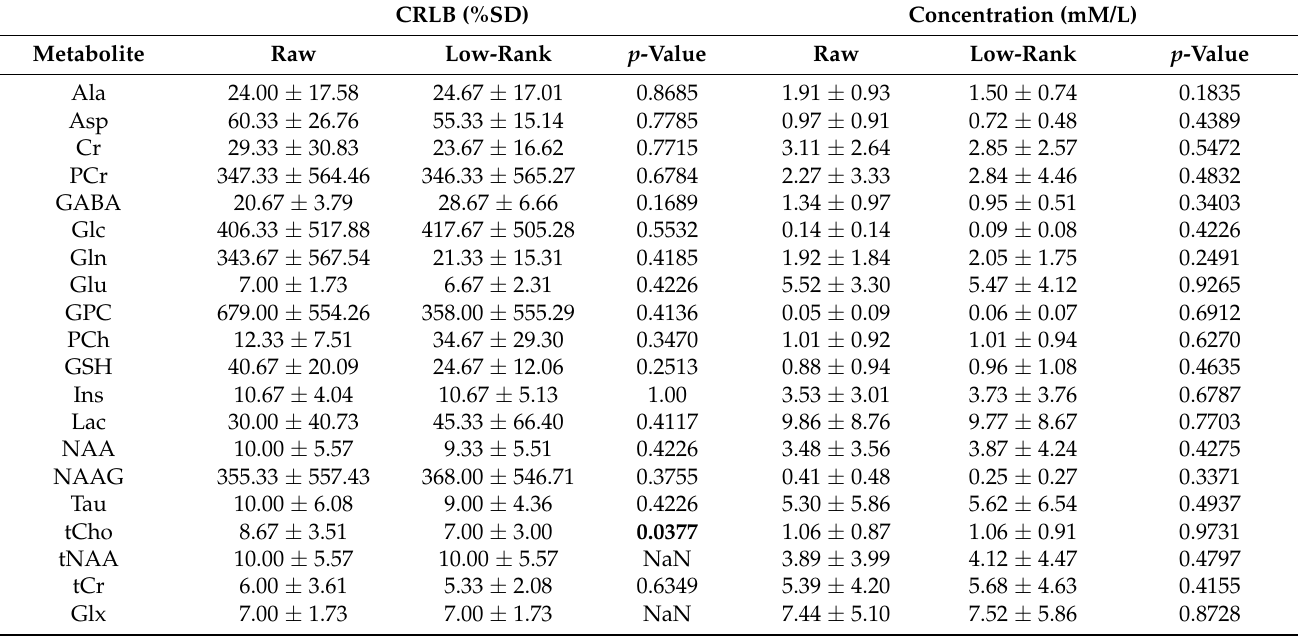
Figure 4. 1 H MRS data acquisition and analysis results. 1 H MRS voxel positioning on stroke lesion (violet-colored box) ( A ), LCModel analysis without denoising ( B ), and LCModel analysis with denoising ( C ). Note: in ( B , C ), the red lines represent LCModel spectral fitting results, and the black lines are target in vivo 1 H spectra ( bottom ) and residual signals ( top ). Glx is Glu + Gln. Table 4. CRLB and concentration differences between raw and denoised 1 H MRS (stroke)